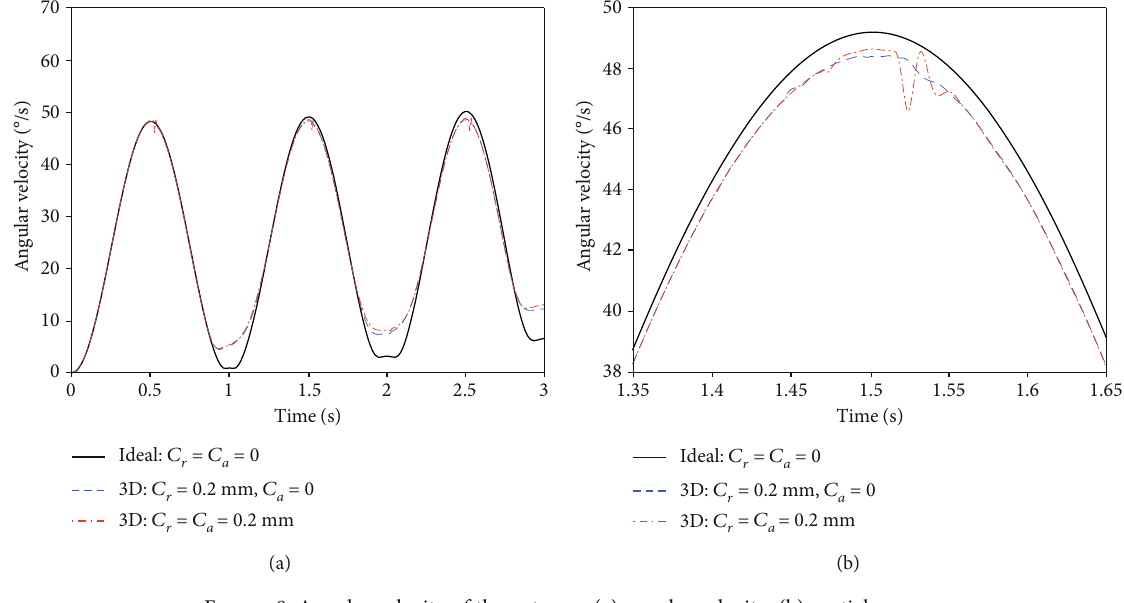
Figure 8: Angular velocity of the antenna: (a) angular velocity; (b) partial zoom.